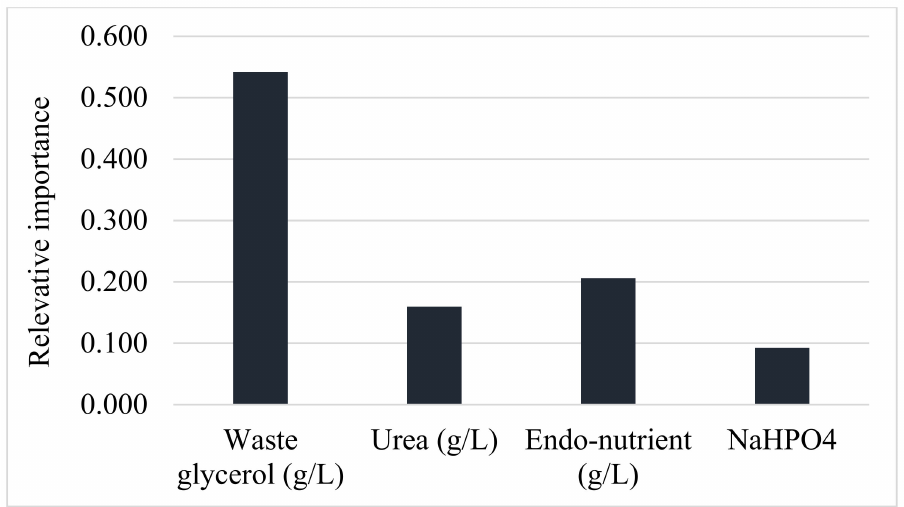
Figure 7. Analysis of the relative importance of input variables on predicted biohydrogen